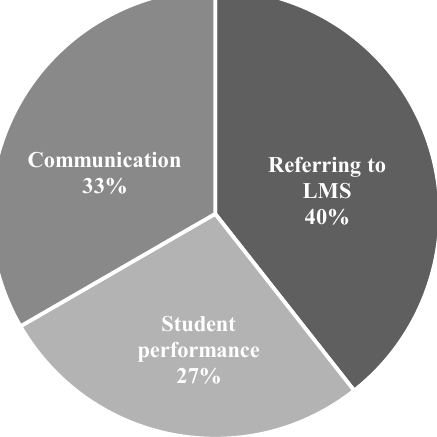
Figure 2 Student Engagement